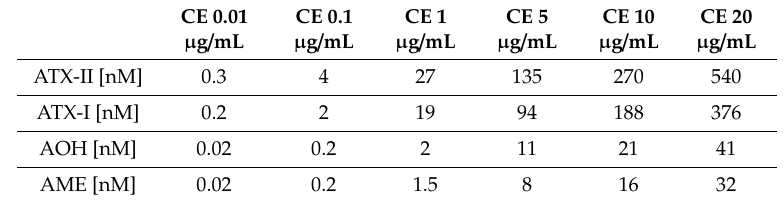
Table 1. Single Alternaria toxin concentrations corresponding to applied concentrations of the